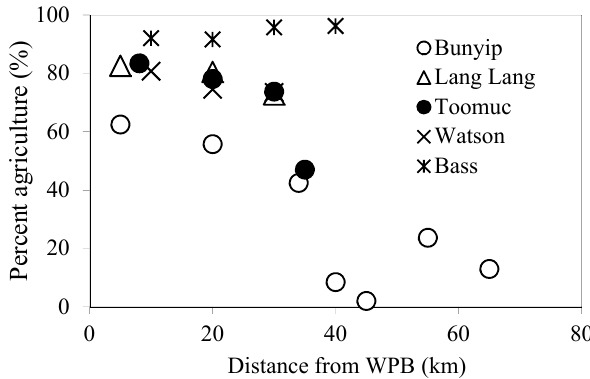
Figure 2. The percent agriculture upstream for each of the sampling